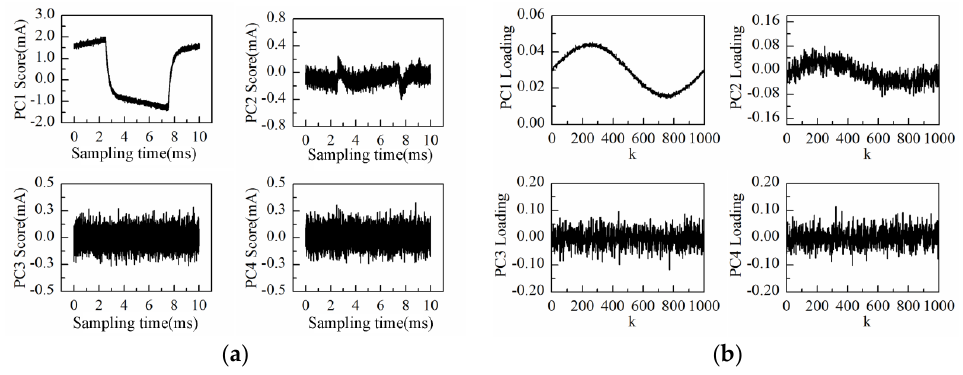
Figure 2. Results after principal component analysis (PCA) processing: ( a ) PC1–PC4 scores plot; ( b ) PC1–PC4 loadings plot.